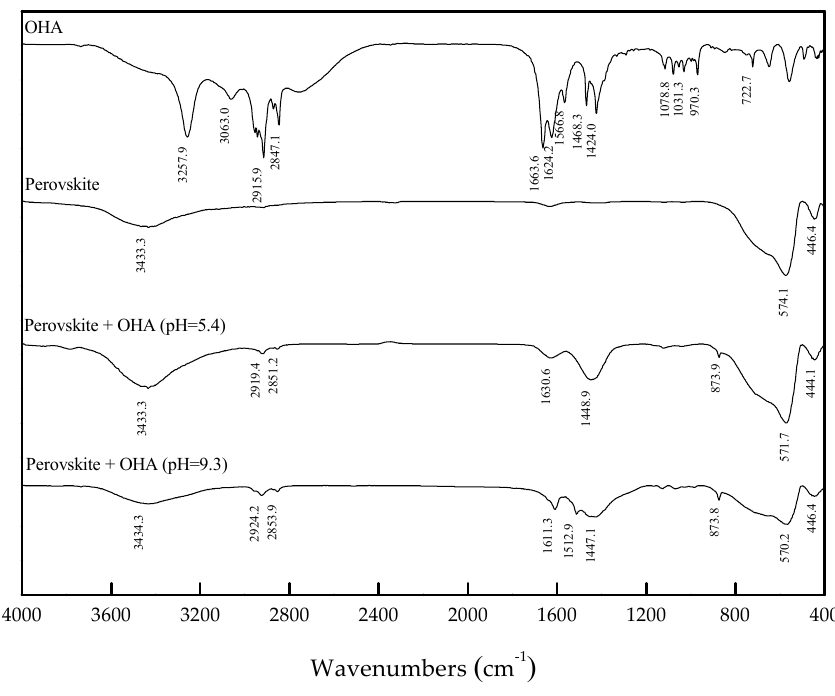
Figure 7. FT-IR spectra of the OHA and perovskite with OHA at different pH levels.